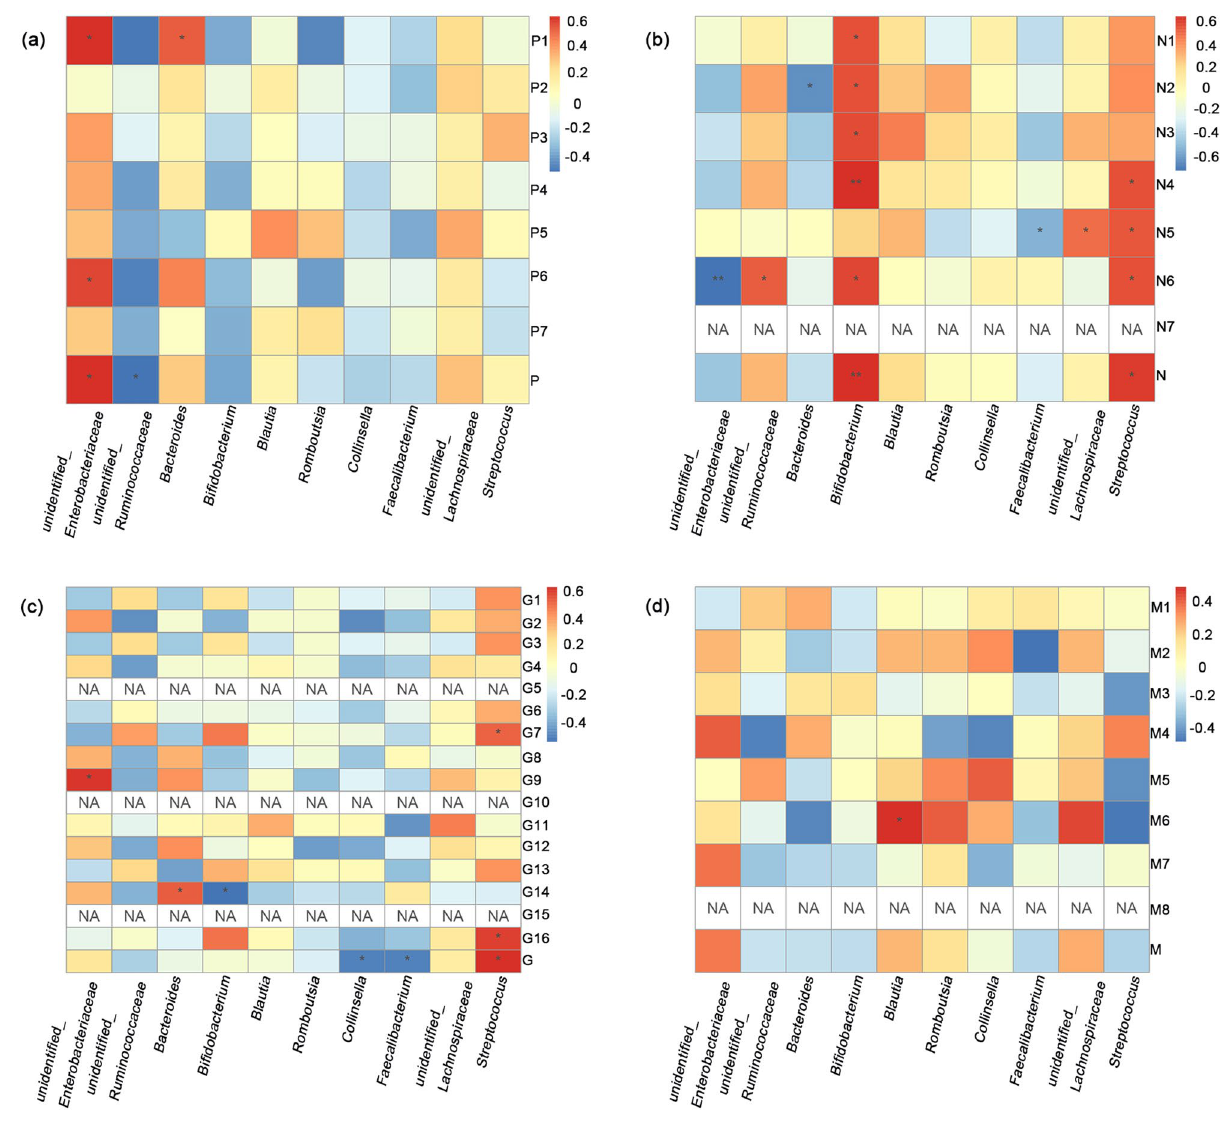
Figure 5. Positive and negative symptoms of schizophrenia as well as general psychopathology and cognition were related to gut microbiota. The correlations between gut microbiota at the genus level for different taxa and ( a ) the positive symptoms of schizophrenia (P1 = delusions, P2 = conceptual disorganization, P3 = hallucinatory behavior, P4 = excitement, P5 = grandiosity, P6 = suspiciousness, P7 = hostility, P = the total positive scale), ( b ) the negative symptoms of schizophrenia (N1 = blunted affect, N2 = emotional withdrawal, N3 = poor rapport, N4 = passive-apathetic social withdrawal, N5 = difficulty in abstract thinking, N6 = lack of spontaneity and flow of conversation, N7 = stereotyped thinking, N = the total negative scale) and ( c ) general psychopathology (G1 = somatic concern, G2 = anxiety, G3 = guilty feelings, G4 = tension, G5 = mannerisms and posturing, G6 = depression, G7 = motor retardation, G8 = uncooperativeness, G9 = unusual thought content, G10 = disorientation, G11 = poor attention, G12 = lack of judgment and insight, G13 = disturbance of volition, G14 = poor impulse control, G15 = preoccupation, G16 = active social avoidance, G = general psychopathology scale) from PANSS and ( d ) the MoCA (M1 = visuospatial executive, M2 = naming, M3 = attention, M4 = calculation, M5 = language, M6 = abstract, M7 = delayed recall, M8 = orientation, M = the total MoCA scale). Spearman rank correlation, * p < 0.05, ** p <